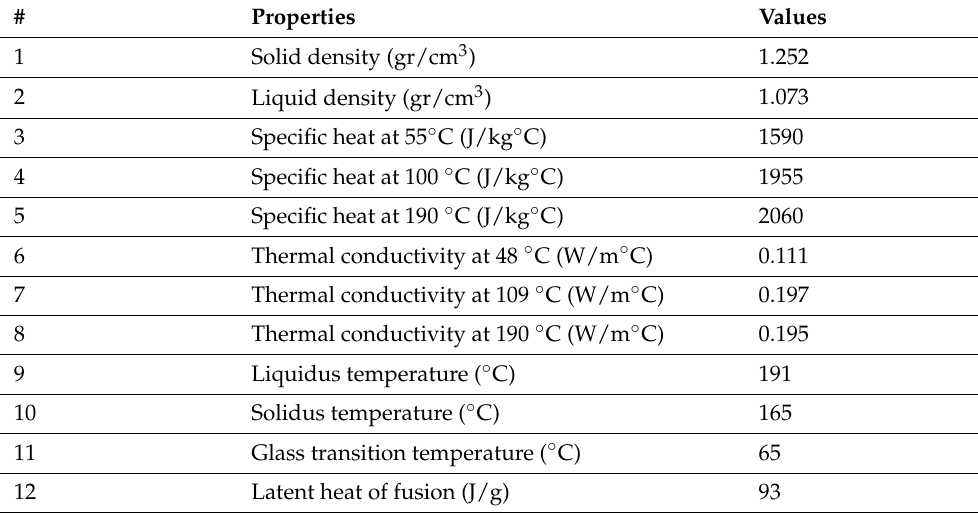
Table 6. Properties of PLA material.